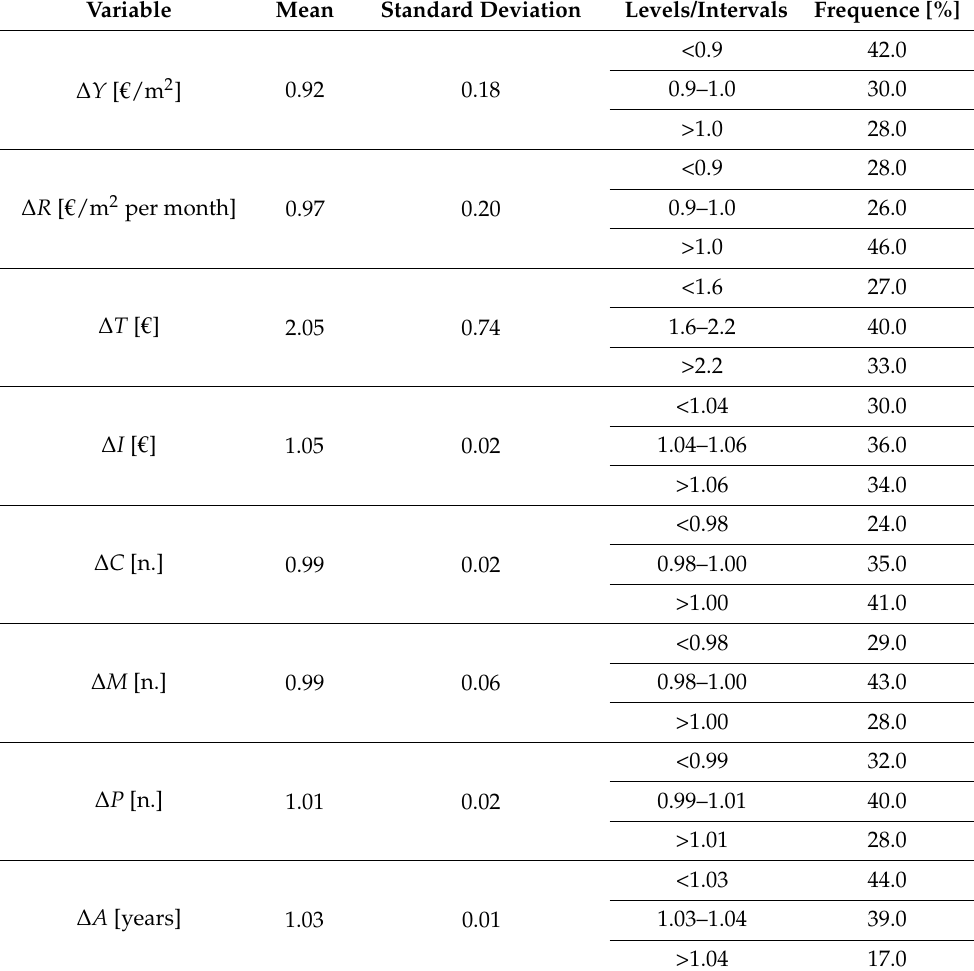
Table 3. Descriptive statistics of the variables used in the econometric analysis.